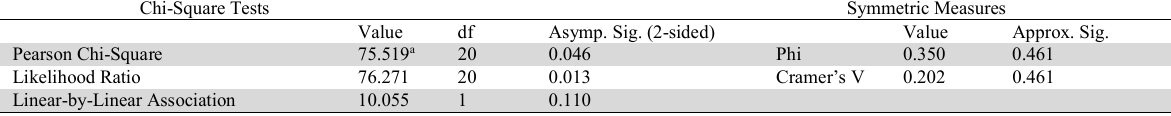
Chi-Square and Cramer’s V results for educational level difference in entrepreneurial intention Chi-Square Tests